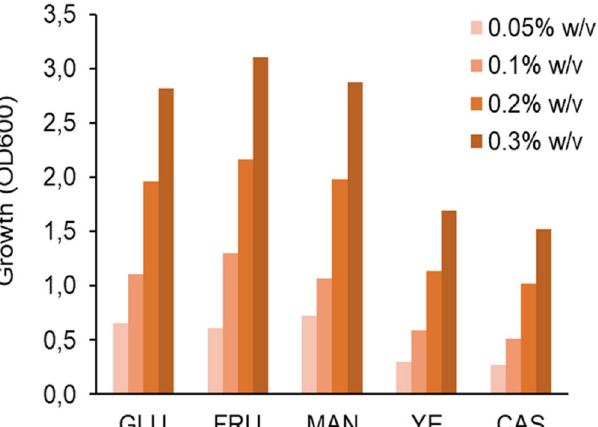
0.05) between temperatures ≤